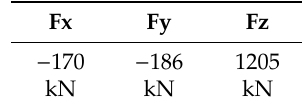
Table 2. Resulting force on the support.